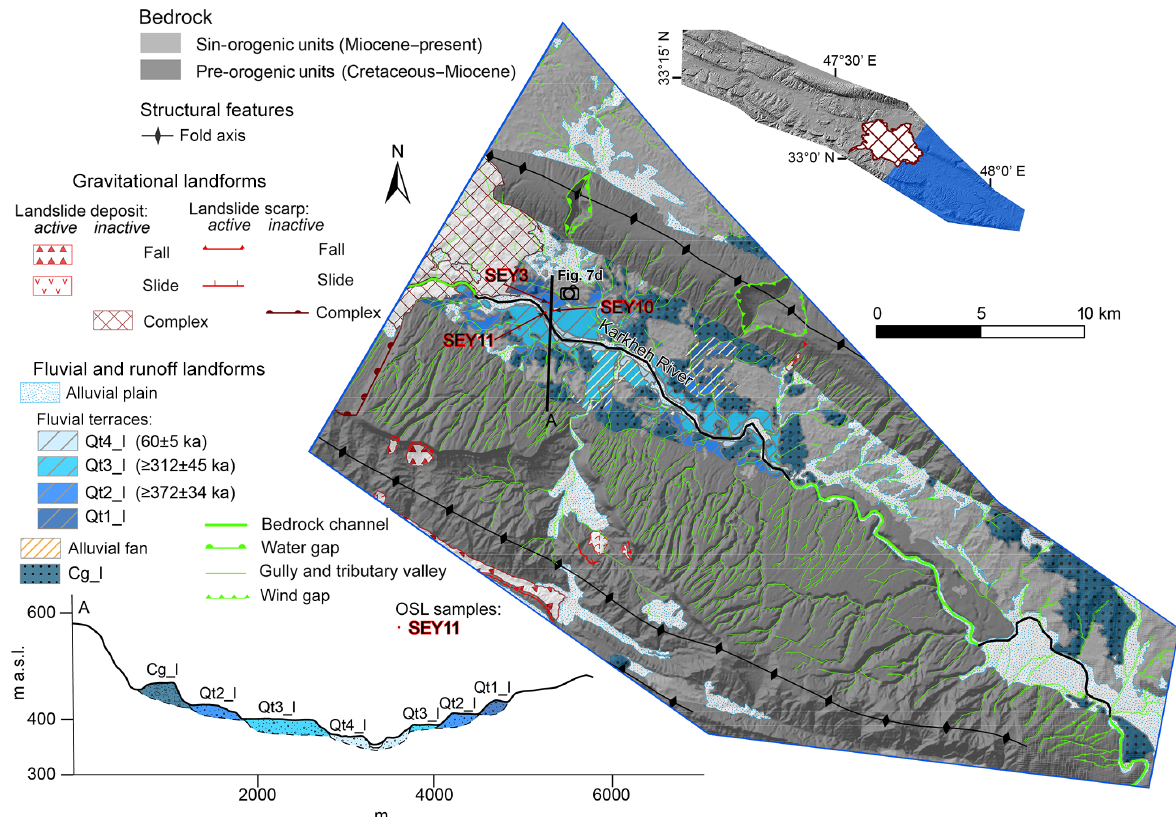
Figure 8. Map of the alluvial terrace suite and of the most significant landforms for the valley slope evolution downstream of the Seymareh